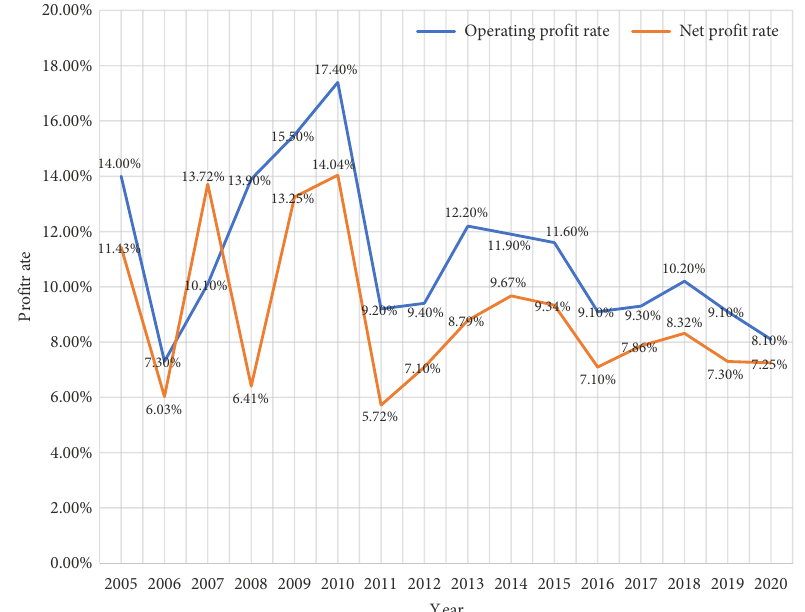
Figure 9. Profitability in 2005–2020